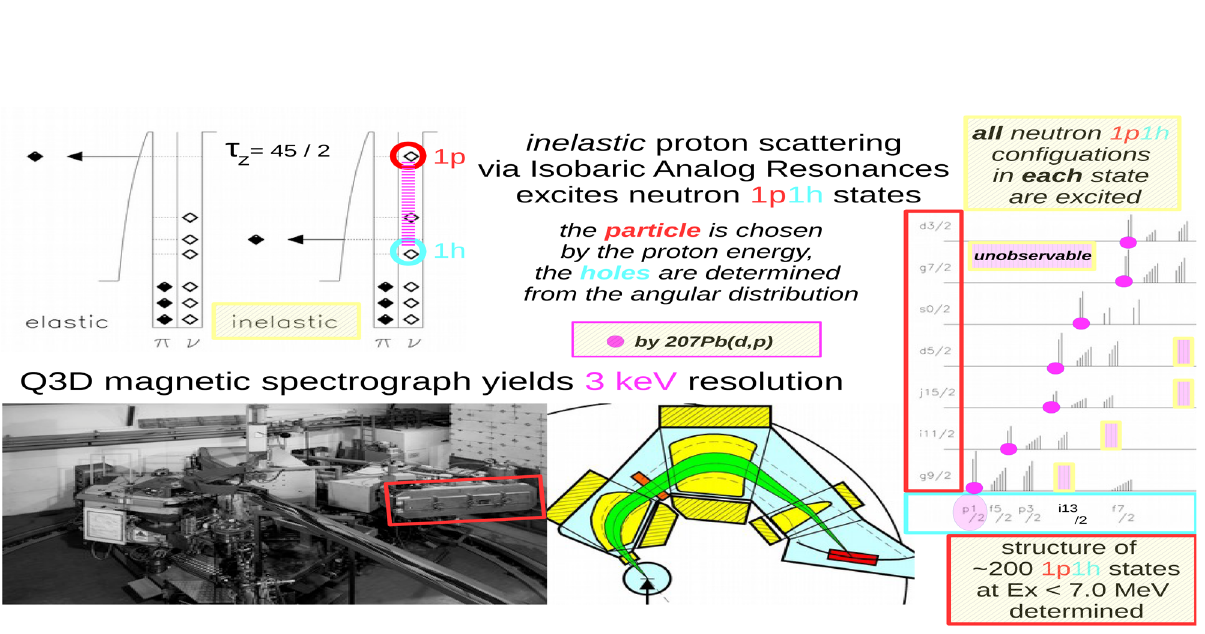
Figure 2. (upper and right frames) Schematic presentation of the reaction 208 Pb( p , p ′ ) via IARs in 209 Bi. (lower left frames) The quadrupole 3-dipole (Q3D) magnetic spectrograph at the MLL (Garching,